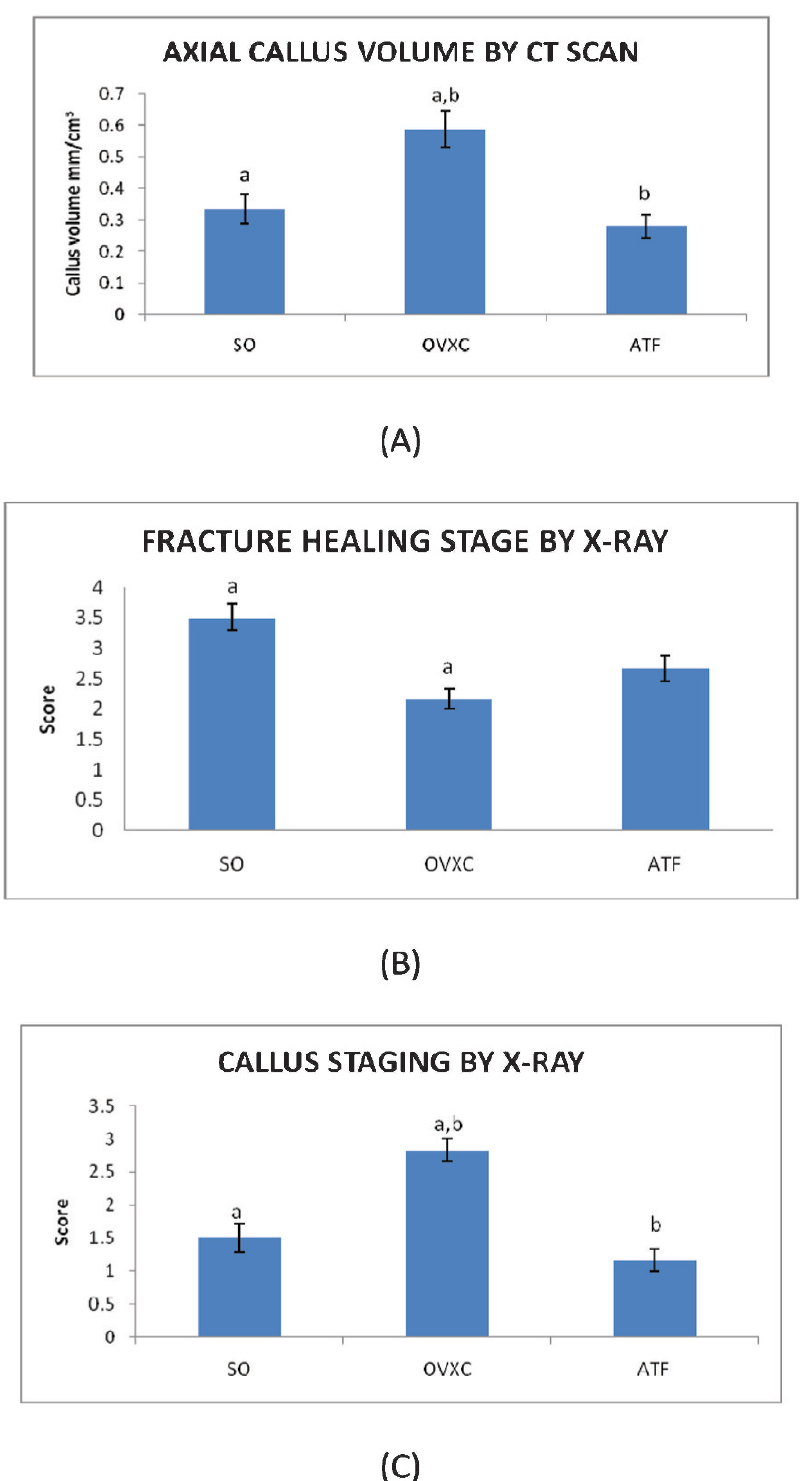
Figure 3 - (A) The bar chart indicates the axial callus volumes, which were measured and calculated using CT scanning. (B) The bar chart indicates the fracture healing stages obtained from the radiological scoring of X-ray images. (C) The bar chart indicates the callus staging scores obtained from the radiological scoring of X-ray images. SO: sham-operated group; OVXC: ovariectomized control group; ATF: ovariectomized + ATF-supplemented group; Values with the same alphabetical symbol are significantly different at p ,